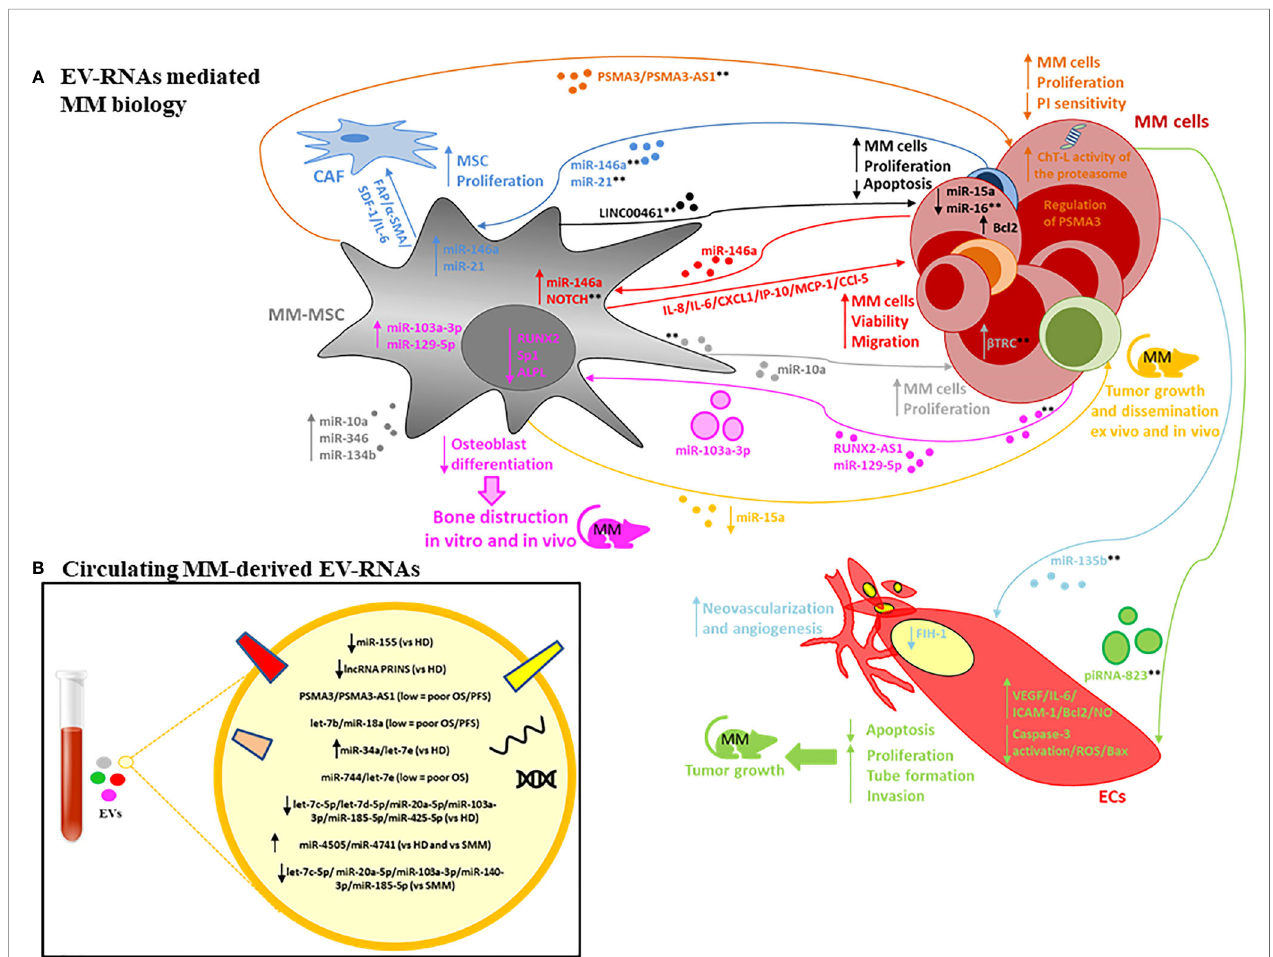
FIGURE 1 | (A) EV-RNAs involved in MM pathobiology. The RNA content of MM-derived EVs is involved in mesenchymal stromal cells (MSC) proliferation and cancer-associated fi broblasts (CAF) transformation (dark-blue lines); neovascularization and angiogenesis, promoting endothelial cell (ECs) proliferation, invasion, reduced apoptosis and the release of angiogenic factors (light-blue and green lines); bone disease by altering osteoblast differentiation (pink line). Finally, MM-derived EV-RNAs enhance tumour cell viability and migration by altering NOTCH pathway and miR-146a levels in MSC with increased secretion of factors such as IL-6, CCl-5, MCP-1 (red lines). The RNA content of MSC-derived EVs is involved in tumour cell proliferation, apoptosis, dissemination, proteasome inhibitors (PI) sensitivity (orange, black, grey, yellow lines). Both large EVs and small EVs are depicted. **indicate possible targets based on use of speci fi c inhibitors, gain or loss of function studies, and EV-secretion inhibitors (see text for description). (B) EV-RNAs identi fi ed within the cargo of circulating EVs isolated from patients with MM, MGUS, SMM vs